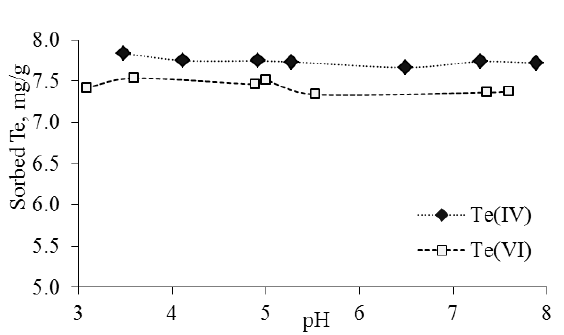
Figure 6: Influence of pH on sorption of Te using Fe-modified peat (Gagu) as a sorbent, sorption time 24 h at room temperature (Te initial concentration 100 mg L -1 ).